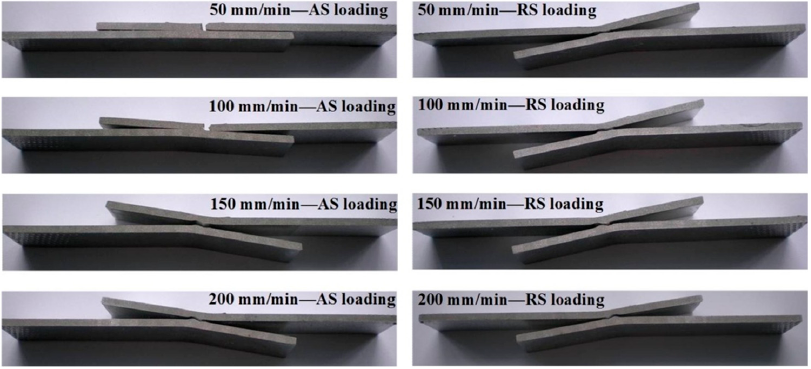
Figure 6. Fracture features of the lap joints.